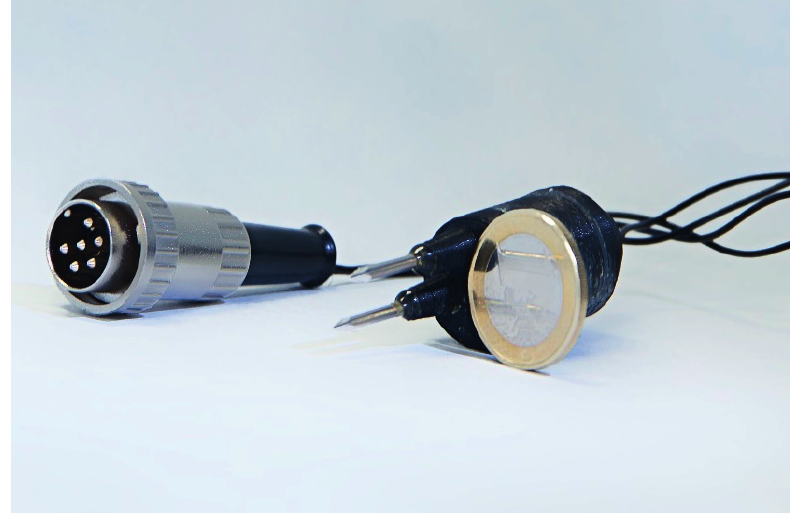
Figure 2. A view of the designed double needle